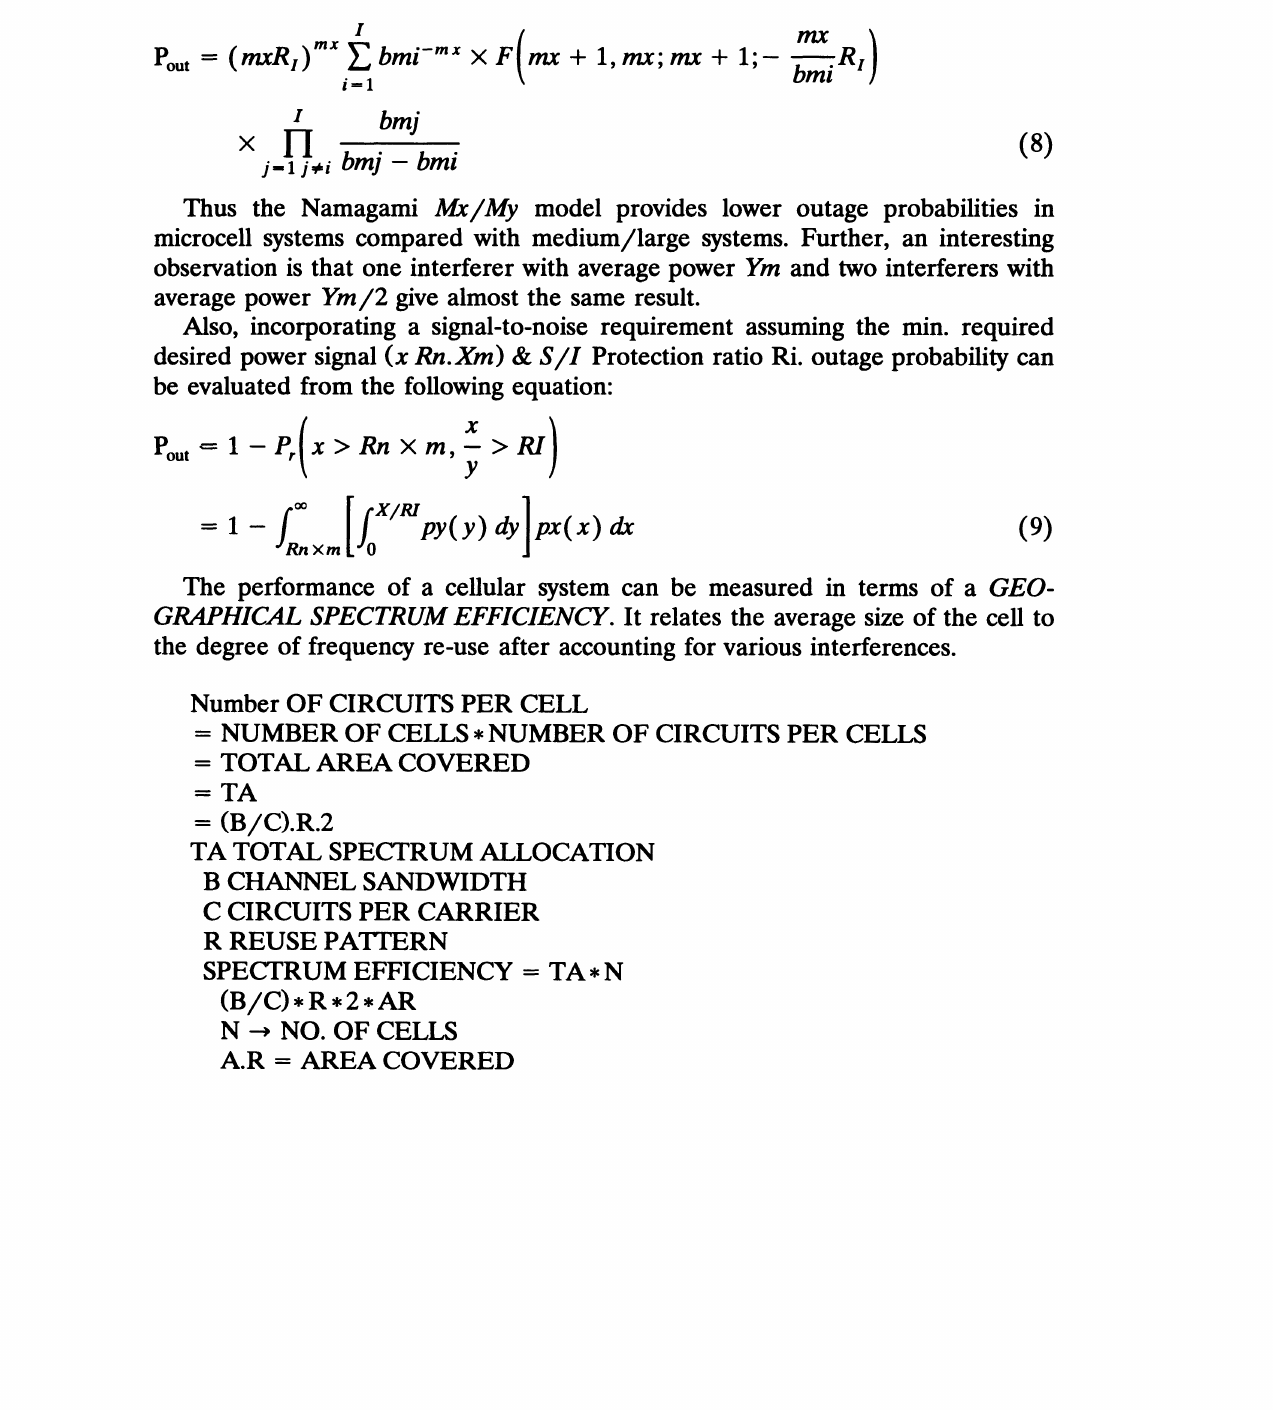
FIGURE 6 OUTAGE PROBABILITY (R/--